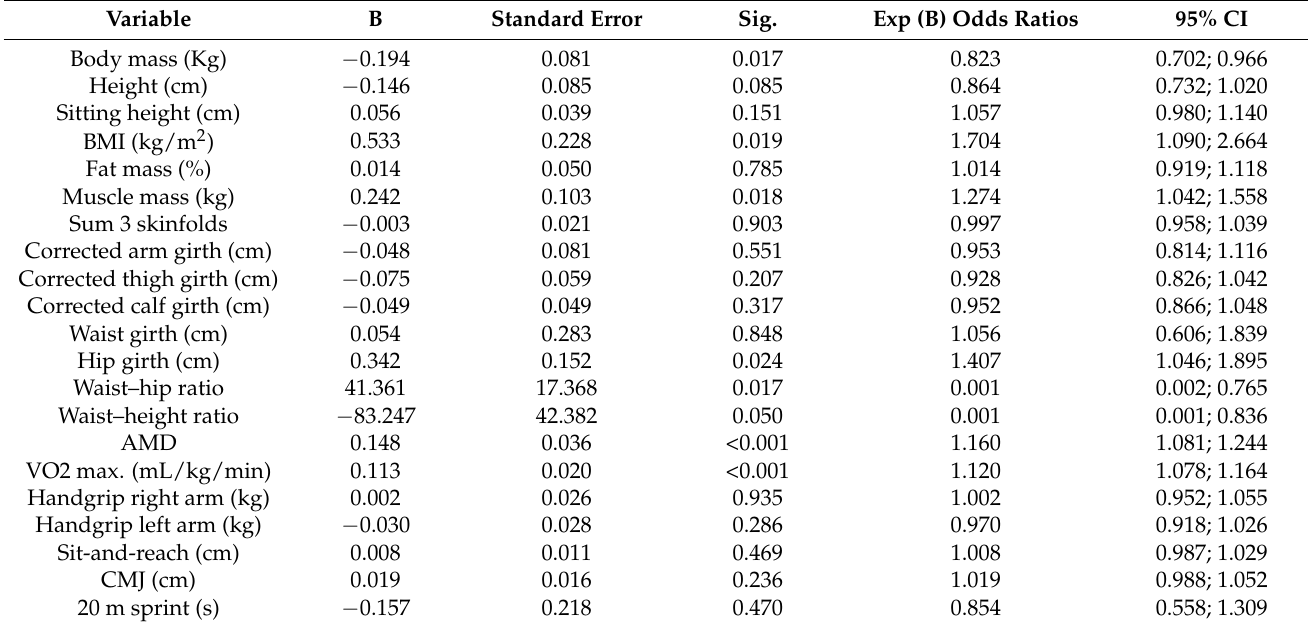
Table 2. Binary logistic regression analysis of the analyzed variables to explain the differences between active and sedentary